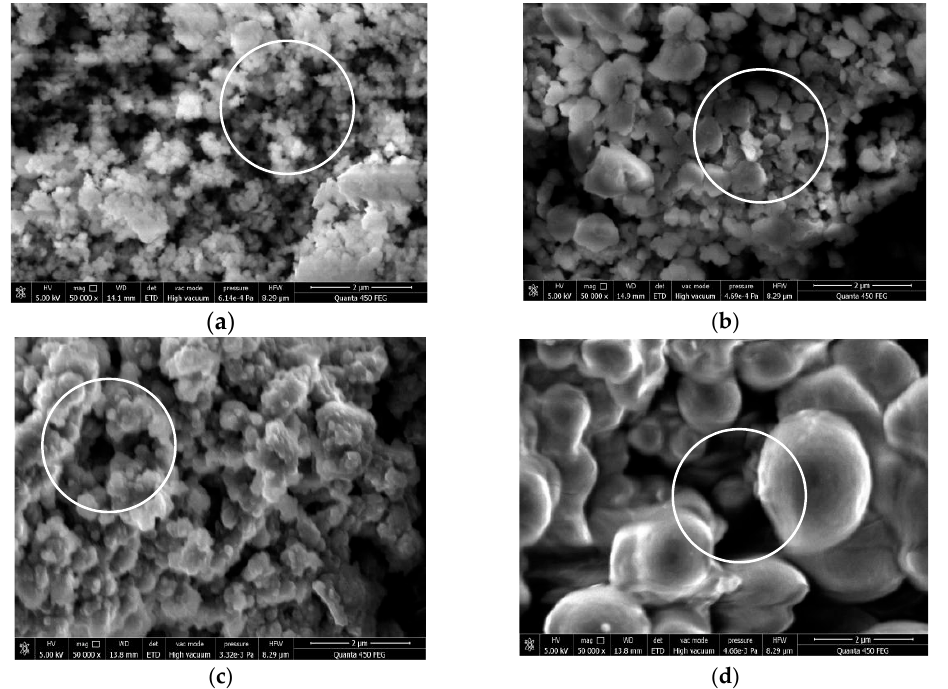
Figure 4. Scanning electron microscope images of lignin and hydrothermal charcoal at magnification 5000 at different holding times (( a ): HL290-0.00, ( b ): HL-290-1.00, ( c ): HL-290-2.00, ( d ): HL-290-8.00).